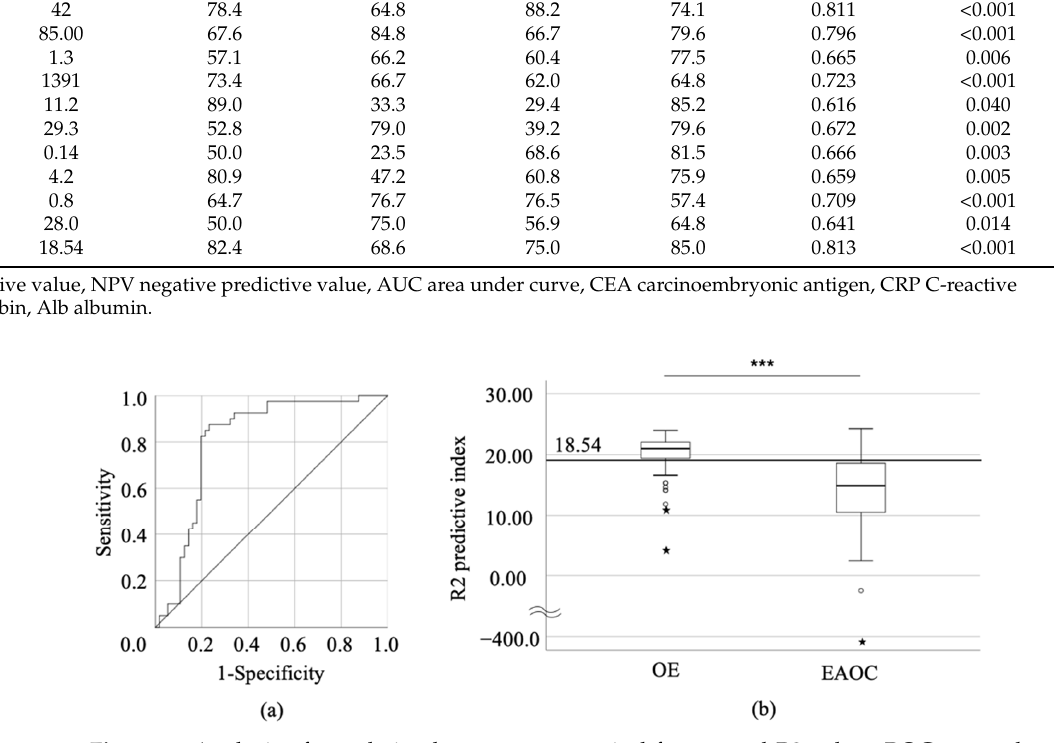
Figure 1. Analysis of correlation between pre-surgical factors and R2 value. ROC curve shows diagnostic effectiveness of R2 predictive index ( a ). ( b ) shows the distribution of R2 predictive index for each studied group as OE ( n = 54) and EAOC patients ( n = 51) ( p < 0.001). *** p < 0.001 vs. control. The circles and pentagrams represent outliers. Table 3. Cut-off values discriminating EAOC from benign OE in the validation cohort.